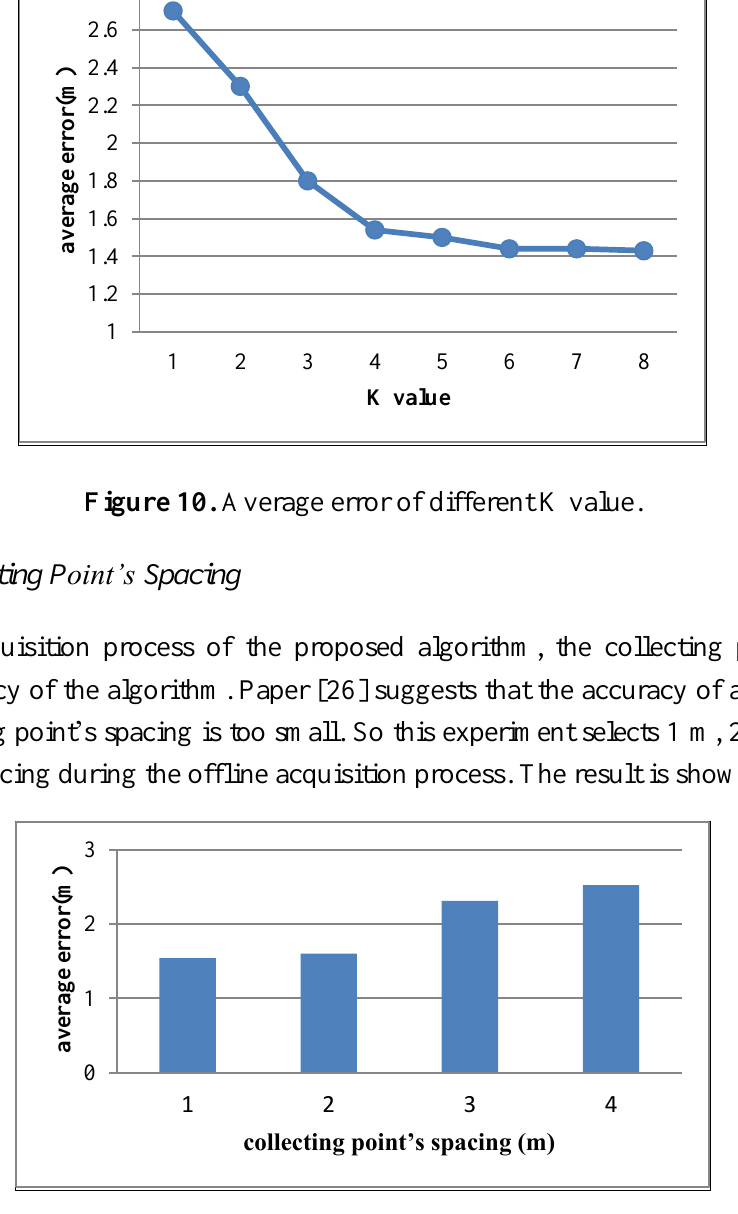
Figure 11. Average error of different collecting point’s